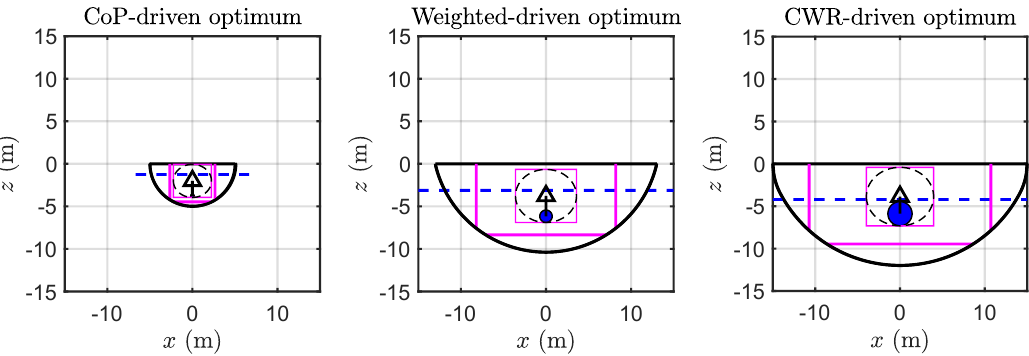
Figure 14. Cross-section of the CoP-driven, the weight-driven and the CWR-driven optima, with common scale and axis dimensions. The pink rectangles represents the ballast compartments and the bulk of the unit. The blue circle is the cross-section of the pendulum mass. The triangular marker represents the fulcrum. The blue dashed line is the still water level.